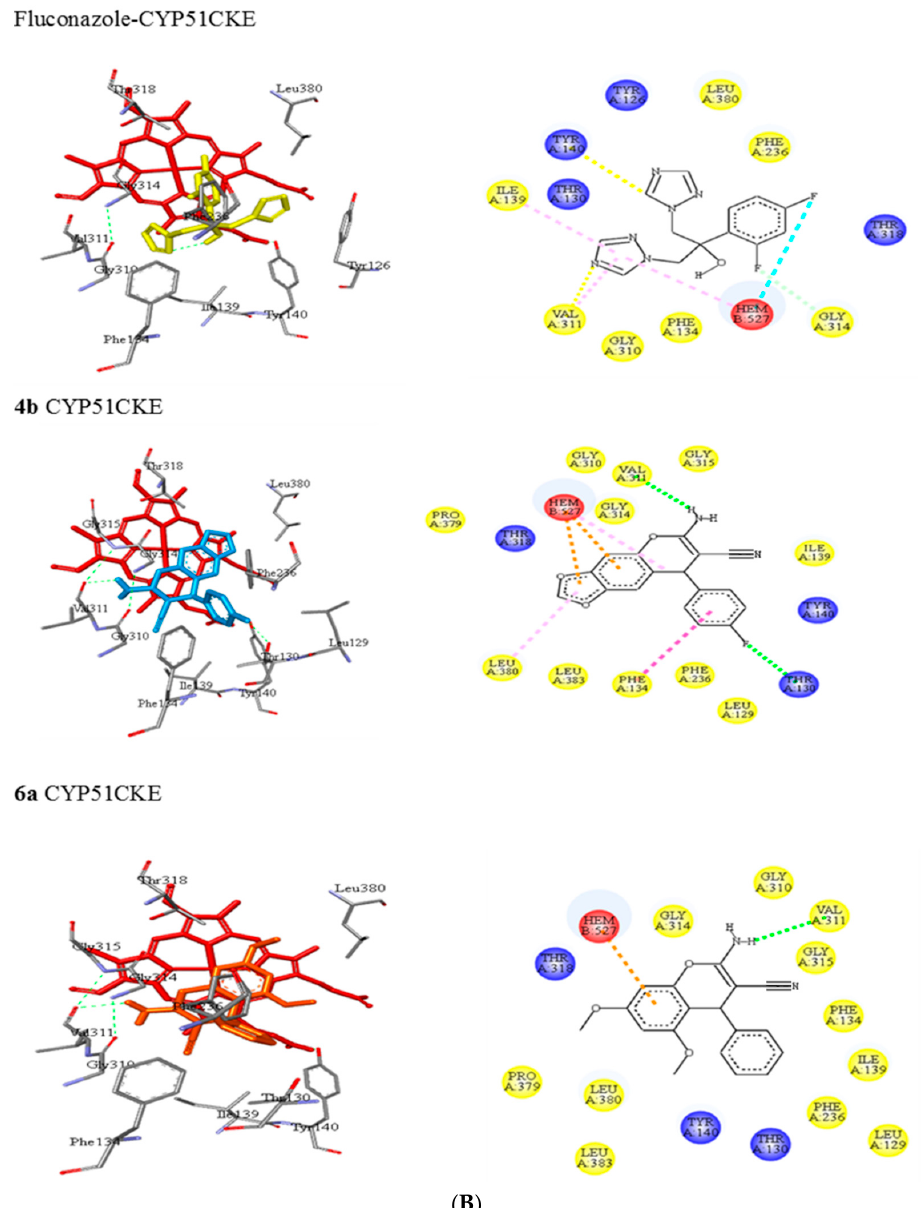
Figure 1. Schematic representation of the following binding modes: ( A ) 4d , 6a , and 8 at the active site of CYP51CD ( C. dubliniensis ), and ( B ) 4b , 6a and 8 at the active site of CYP51CKE ( C. kefyr ). Here, 3D and 2D models are shown. The 3D model depicts the hydrophilic bonds and amino acid residues that are part of the active site of CYP51. In the 2D model, the interactions denoted with dotted lines are conventional hydrogen bonds (green), carbon–hydrogen (yellow), π –cation (orange), π –sigma (purple), π –alkyl (pink), π – π T-shaped (fuchsia), and halogen (cyan). The heme group is in red. The solvent accessible surface is illustrated for the amino acid residues and ligands. The amino acids are highlighted in pink (basic), yellow (hydrophobic), and blue (hydrophilic).